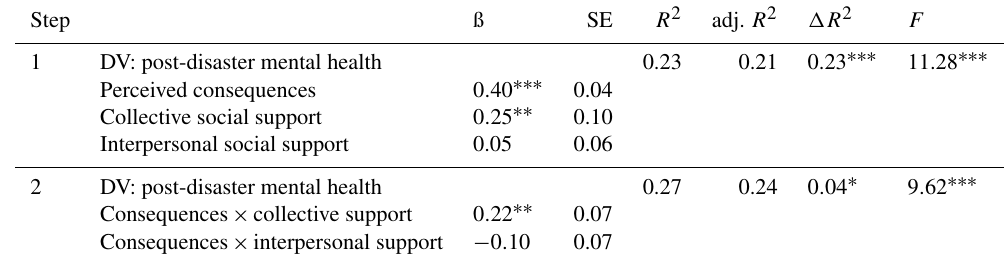
Table 2. Hierarchical regression of the combined post-disaster mental health measure on perceived negative consequences, perceived collec- tive social support (community resilience), perceived interpersonal social support and their interaction terms.